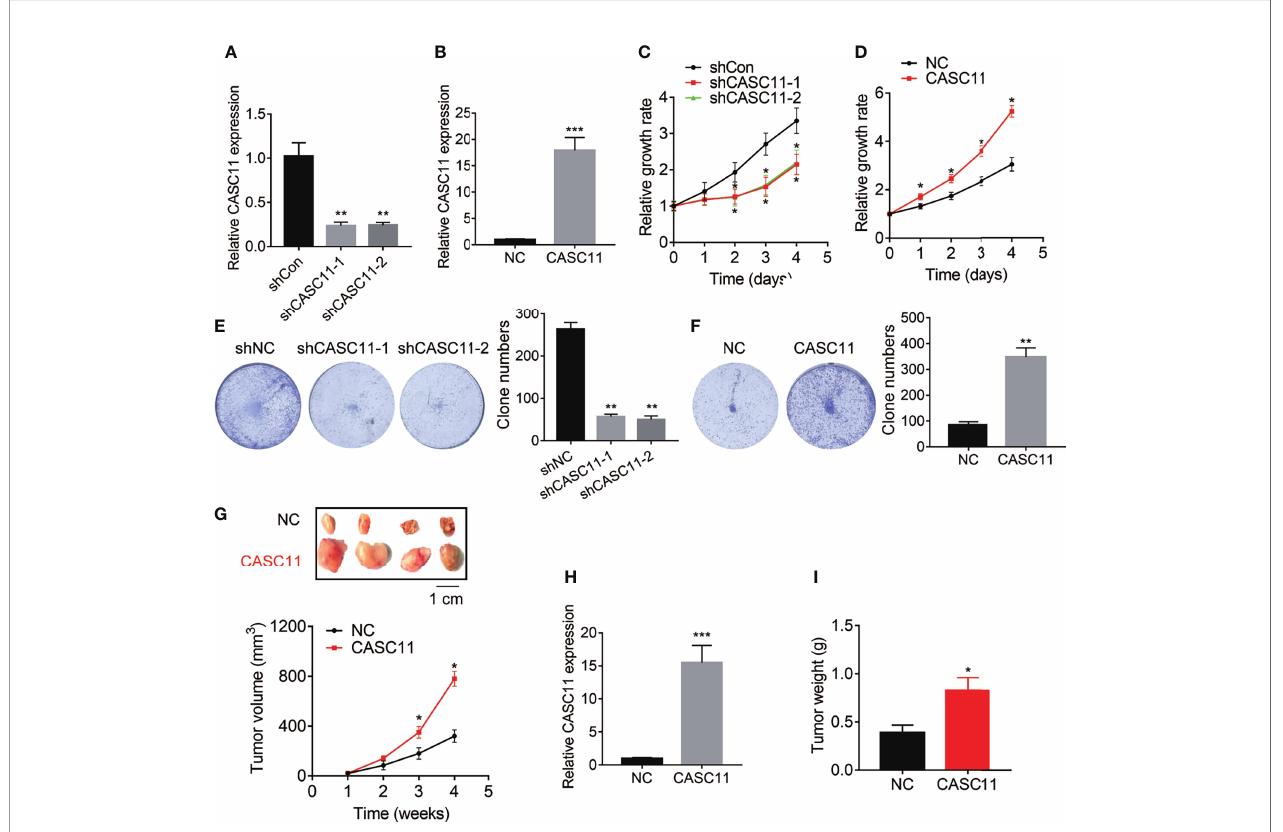
FIGURE 2 | CASC11 promotes HCC cell proliferation in vitro and in vivo . (A) CASC11 was knocked down in Hep3B cells. The knockdown ef fi ciency was validated using qRT-PCR. (B) CASC11 was overexpressed in Huh7 cells. The overexpression ef fi ciency was validated using qRT-PCR. (C) The CCK8 assay was performed in control and CASC11 knockdown Hep3B cells. (D) The CCK8 assay was performed in control and CASC11 overexpressing Huh7 cells. (E) The colony formation assay was performed in control and CASC11 knockdown Hep3B cells. (F) The colony formation assay was performed in control and CASC11 overexpressing Huh7 cells. (G) The tumor growth curve of xenografts formed by control and CASC11 overexpressing Huh7 cells. (H) The CASC11 expression in xenografts formed by control and CASC11 overexpressing Huh7 cells was tested using qRT-PCR. (I) The tumor weight of xenografts formed by control and CASC11 overexpressing Huh7 cells. Data are mean ± SD. *p < 0.05, **p < 0.01, ***p <